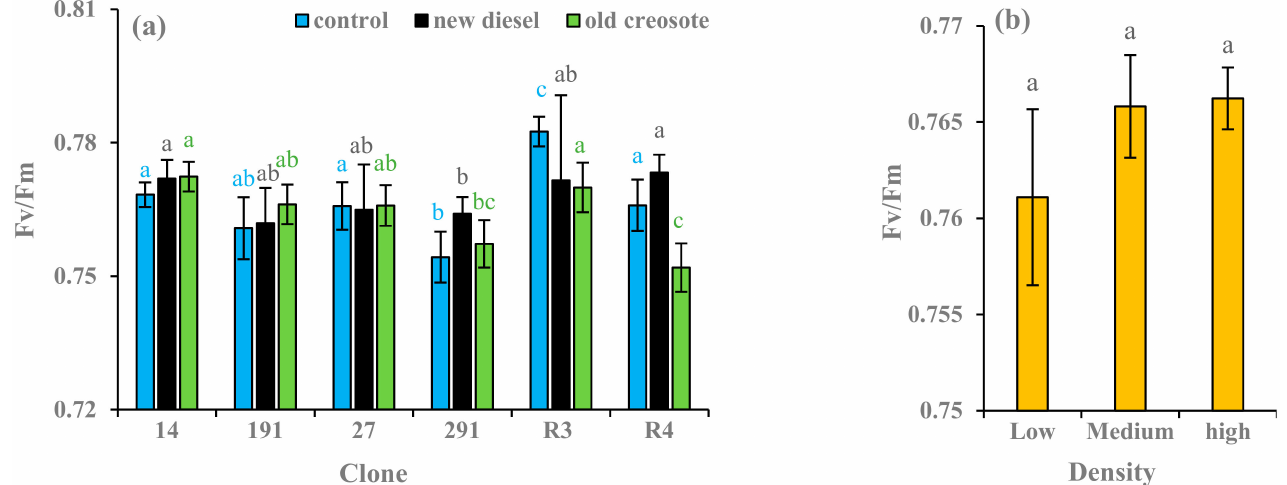
Figure 6. Mean Fv/Fm values ( n = 3) of European aspen and hybrid aspen clones grown in different soil treatments ( a ) and plant densities ( b ). Error bar indicates ± standard error (SE). Means between clones followed by the same lower-case letters with the same font color are not significantly different ( p > 0.05). Means between density treatments followed by the same lower-case letters are also not significantly different ( p >